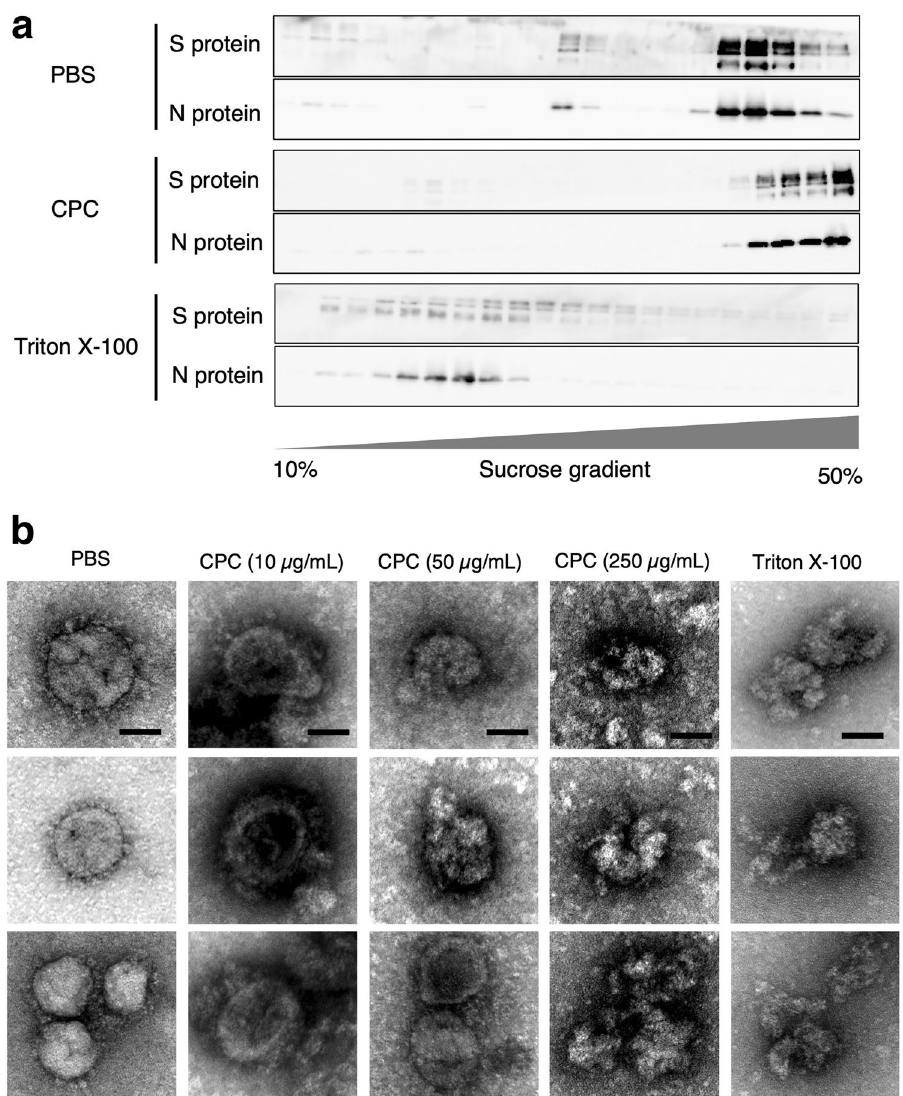
Figure 4. Sucrose density analysis and TEM analysis of SARS-CoV-2 particles. ( a ) Sucrose density analysis of capsid assembly in the presence of 1 × PBS, CPC (50 μg/mL) and Triton X-100 (1%). SARS-CoV-2 Wuhan strain was treated with described regents for 10 min, and the treated virions were applied to the density-gradient ultracentrifugation. Each fraction was applied to SDS-PAGE and analyzed by Western blotting with antibodies against S protein and N protein. ( b ) Electron micrographs of SARS-CoV-2 virions after treatment with reagents. SARS-CoV-2 Wuhan strain was treated with 1 × PBS, CPC (10, 50, 250 μg/mL) and Triton X-100 (1%) for 10 min at room temperature. Each scale bar represents 50